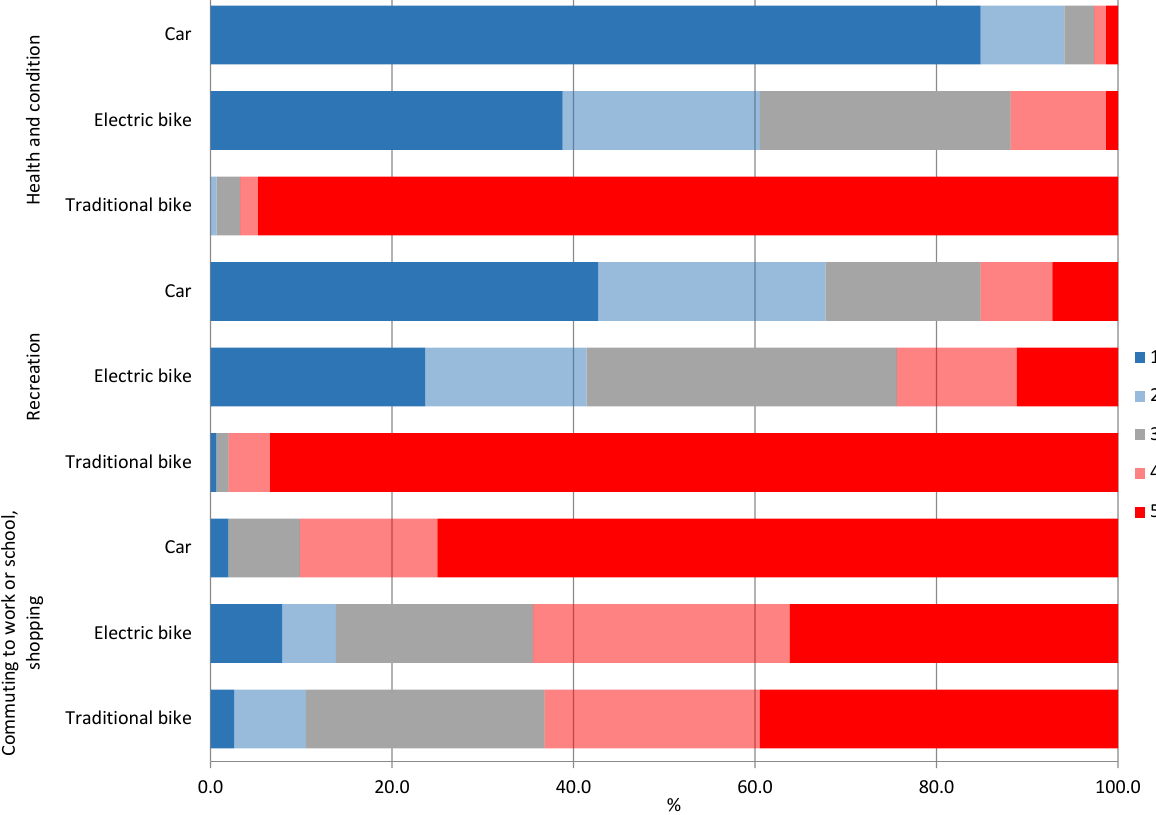
Figure 3. Structure of answers to the question: “Please rate the following means of transport in the aspects indicated (1—not suitable, 5—best suitable)”. Source: Own elaboration on the basis of the questionnaire survey.